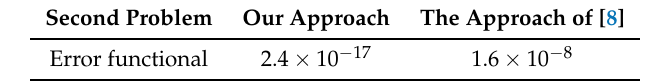
Table 2. Comparison of our approach using the implicit Euler method and the approach proposed in [8].